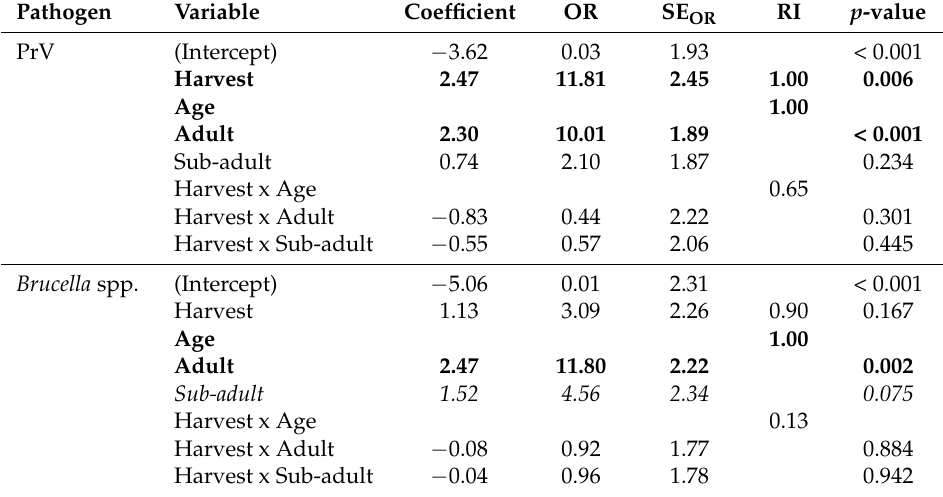
Table 4. Model-averaged parameter estimates, odds ratios (ORs), and relative importance (RI) for the effects of harvest method, wild pig age, and the interaction between harvest method and age on pseudorabies virus (PrV) or Brucella spp. exposure. Values in bold denote statistical significance ( p < 0.05) of the corresponding predictor variables. Italics signify borderline significance (0.05 < p <